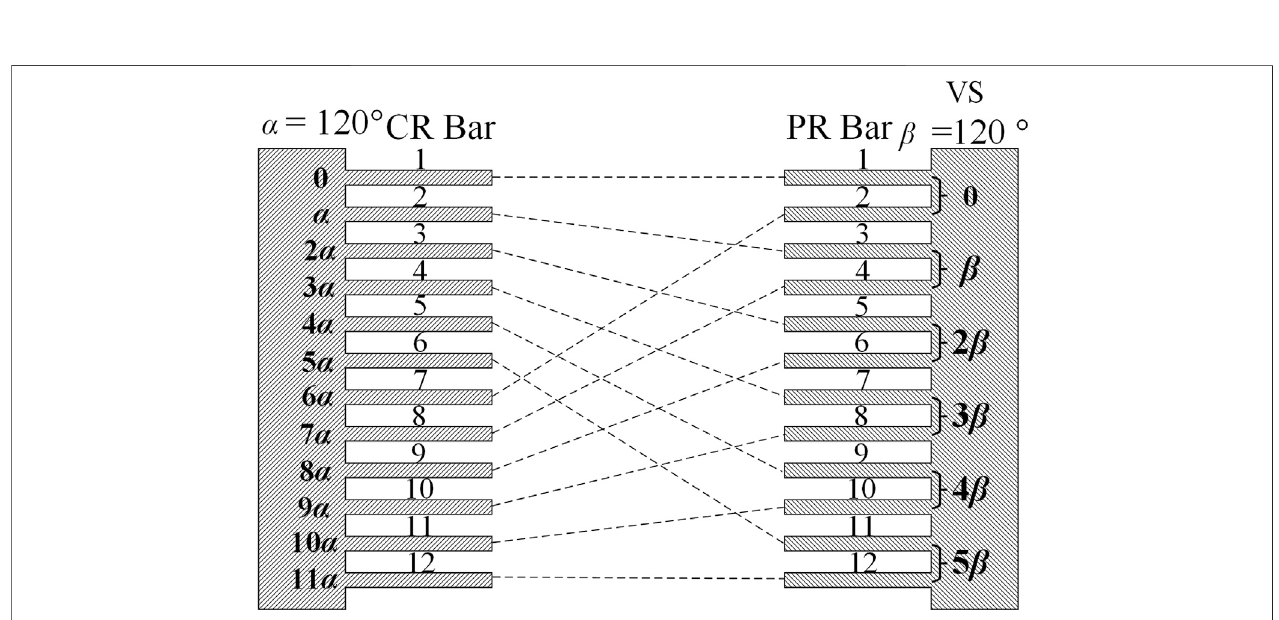
FIGURE 5 | Interconnection between PR bars (2 pole pairs, 12 slots and 6 VSs) and CR bars (4 pole pairs and 12 slots).